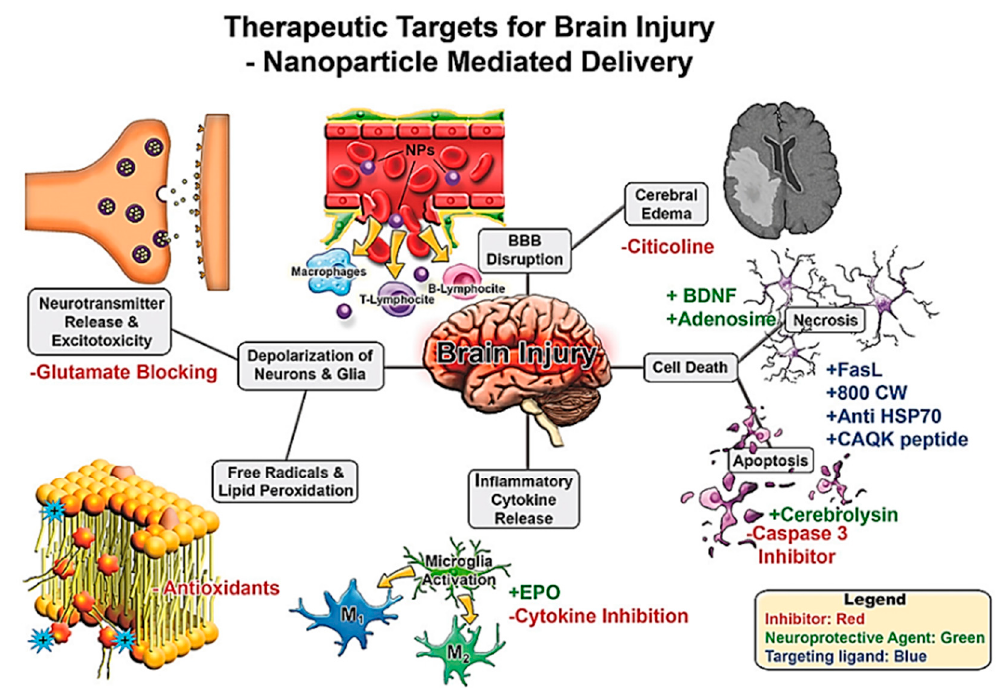
Figure 11. Therapeutic targets for brain injury for nanoparticle mediated drug delivery. Brain injury leads to a cascade of secondary damage events (denoted in grey boxes). These secondary injuries are potential targets for therapeutics where NP delivery may be useful. Potential intervention strategies are highlighted with red/green/blue font where inhibitors/blocking agents are in red, neuroprotective agents via pathway modulation in green, and targeting ligands in blue. Reproduced from [178], with permission from John Wiley and Sons, 2017.